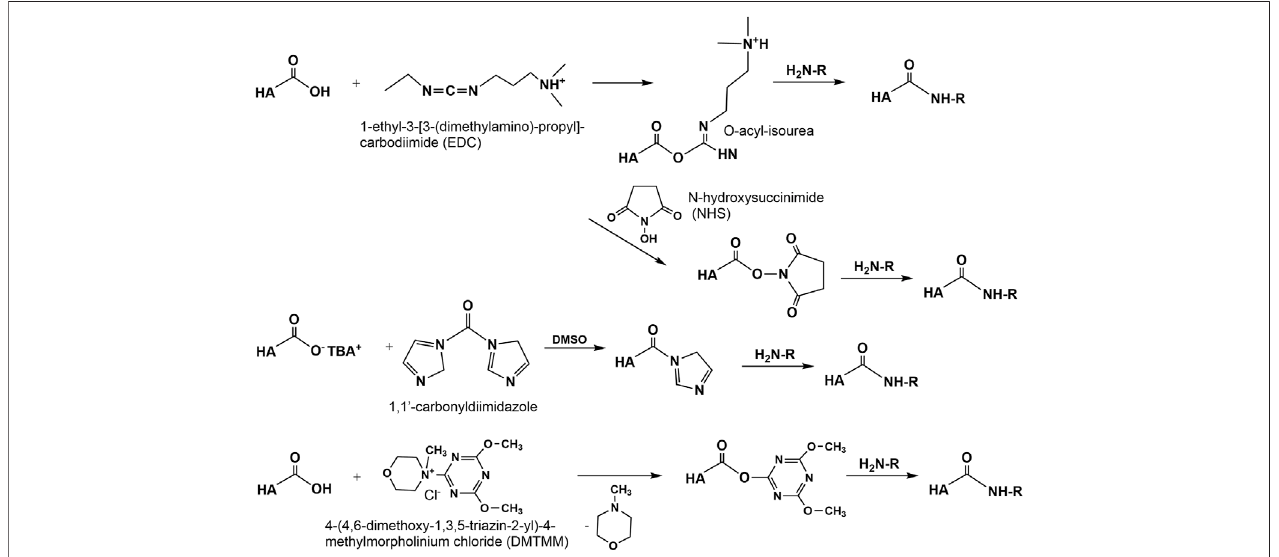
Frontiers in Chemistry |